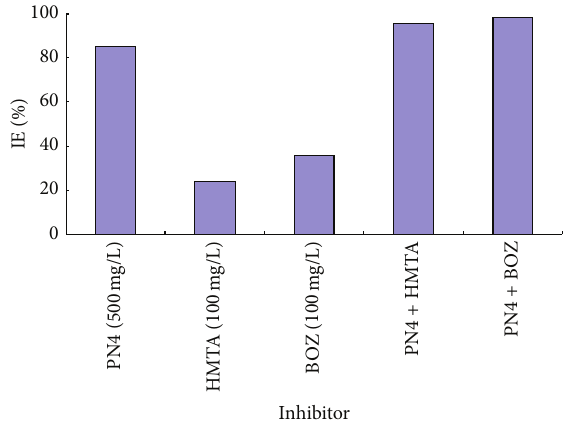
Figure 3: The IE of PN4 companied with HMTA or DHBY.